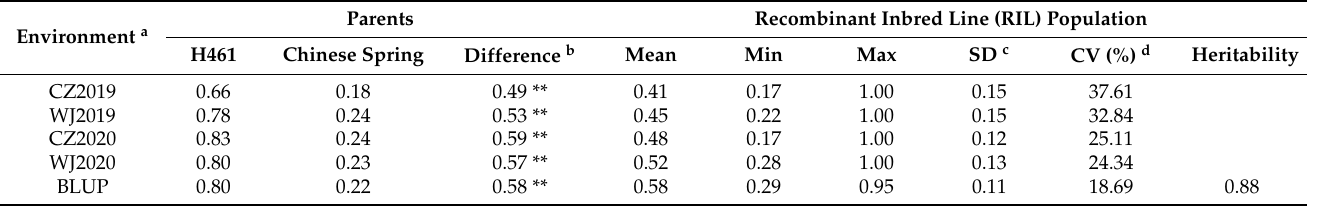
Table 2. Phenotypic variation and the broad-sense heritability of spike-layer uniformity in different environments.